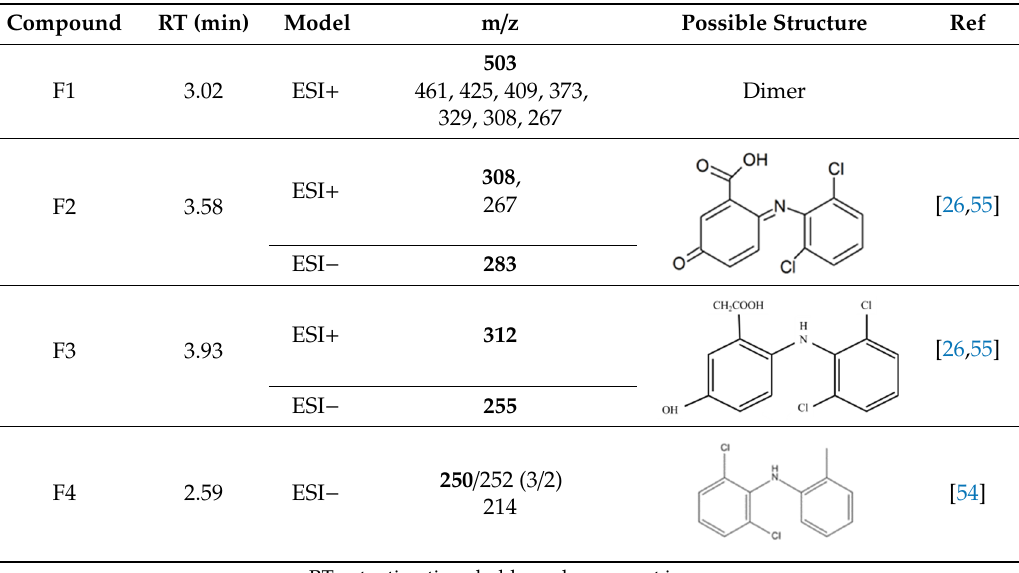
Supplementary Materials: The following are available online: www.mdpi.com/xxx/s1, Figure S1: DIC species distribution versus solution. HA and A − represent the acid and ionized form of DIC, respectively. The black and gray line were calculated based on pKa = 4.15 of DIC [44]. When pH higher than 7, the ionized species (A − ) accounts for 100% of DIC in solution pH. Figure S2: LC–MS chromatographic patterns of degradation intermediates (a) TIC in ESI + mode (b) MS patterns in ESI + mode under pH 7.0 for reaction time = 24 h with initial MnO 2 loading 200 mg.